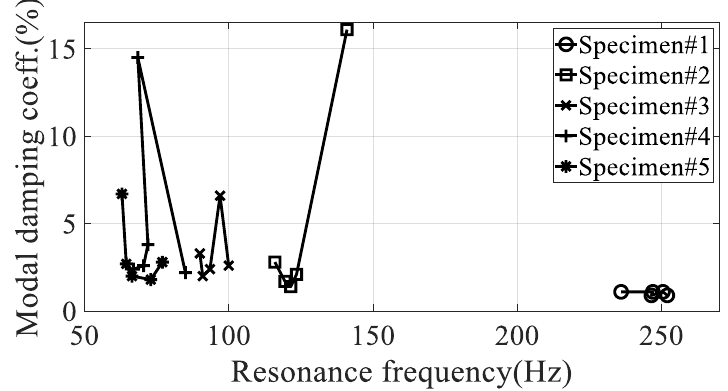
Figure 12. Relationship between resonance frequencies versus modal damping coefficients.